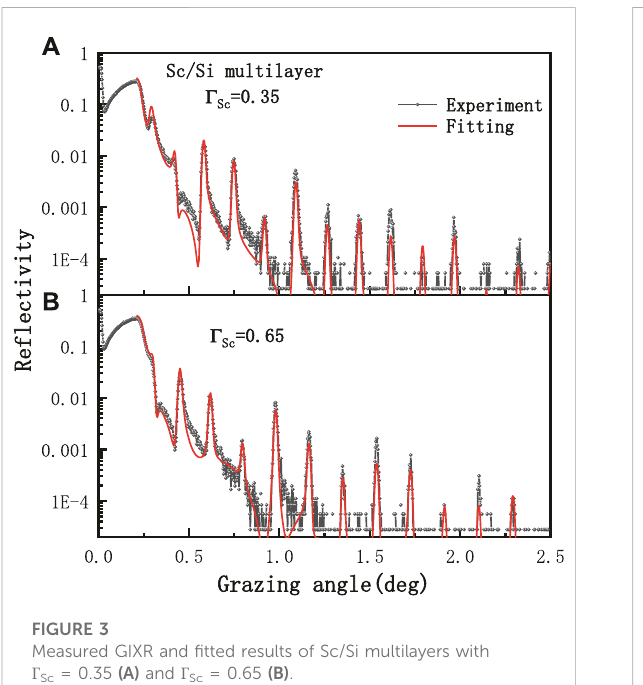
FIGURE 3 Measured GIXR and fi tted results of Sc/Si multilayers with Γ (A) and Γ (B) . Sc = 0.35 Sc = 0.65